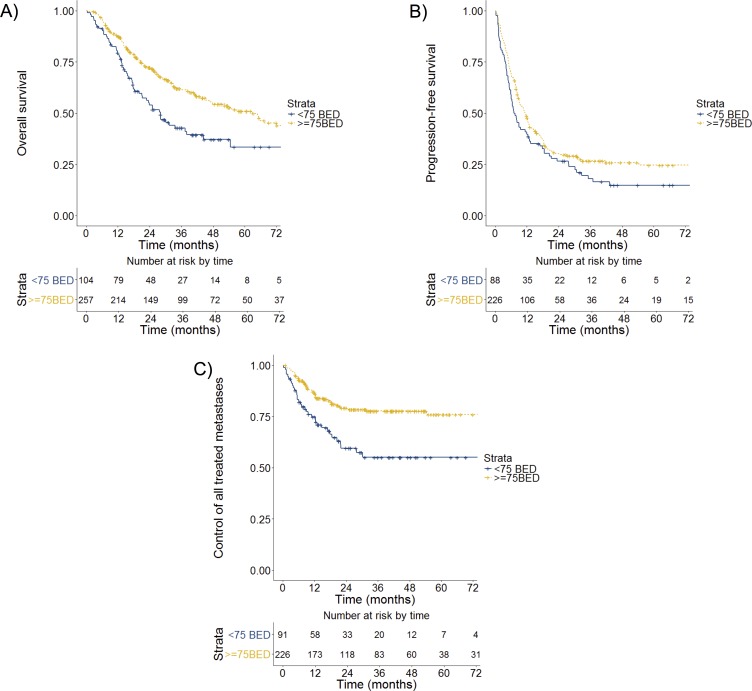
Overall and progression free survival, treated metastasis control by minimum biologically effective dose (BED).BED ≥75 Gy was associated with greater overall survival (p < 0.01) (A) and treated metastasis control (p < 0.01) (C), with trend for progression free survival (p = 0.06) (B).